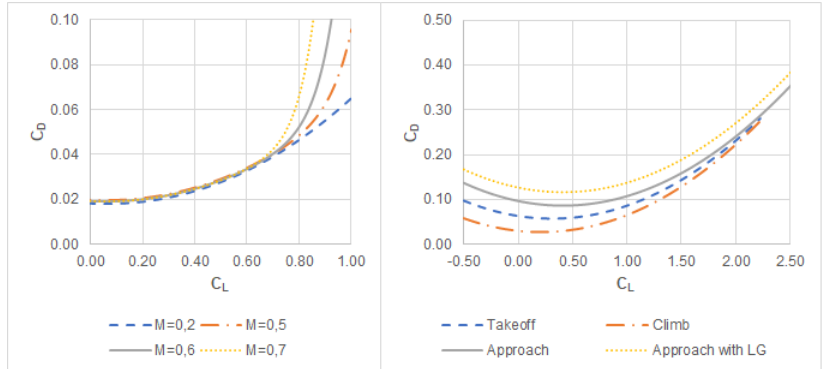
Figure 1. Airplane drag polar of CSR-01 in clean configuration for different Mach numbers ( left ); and in take-off, climb, approach and final approach with landing gear extended conditions ( right